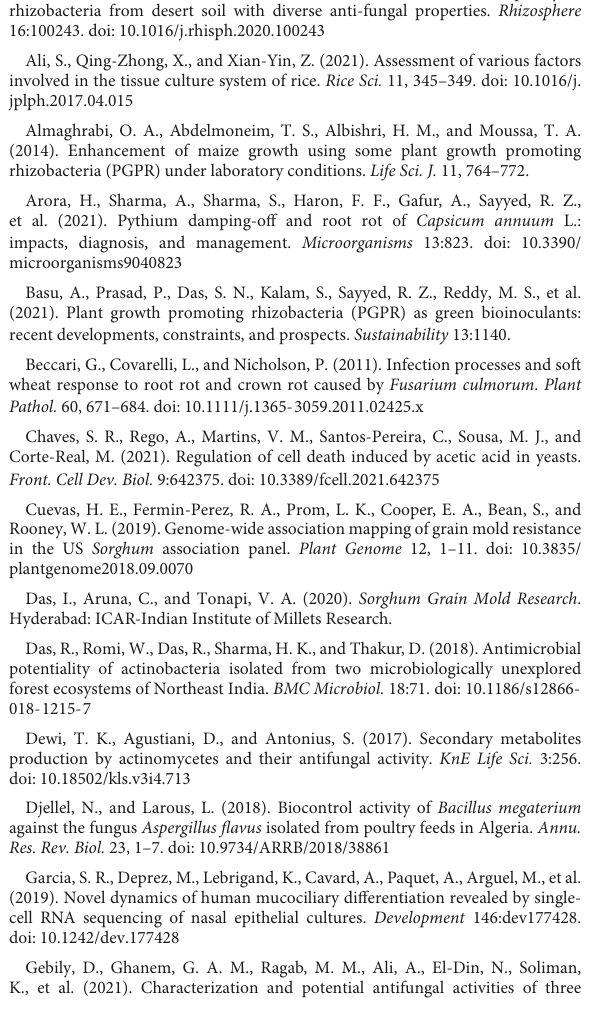
SUPPLEMENTARYFIGURE1 Molecular identification of sorghum grain mold pathogens using specific